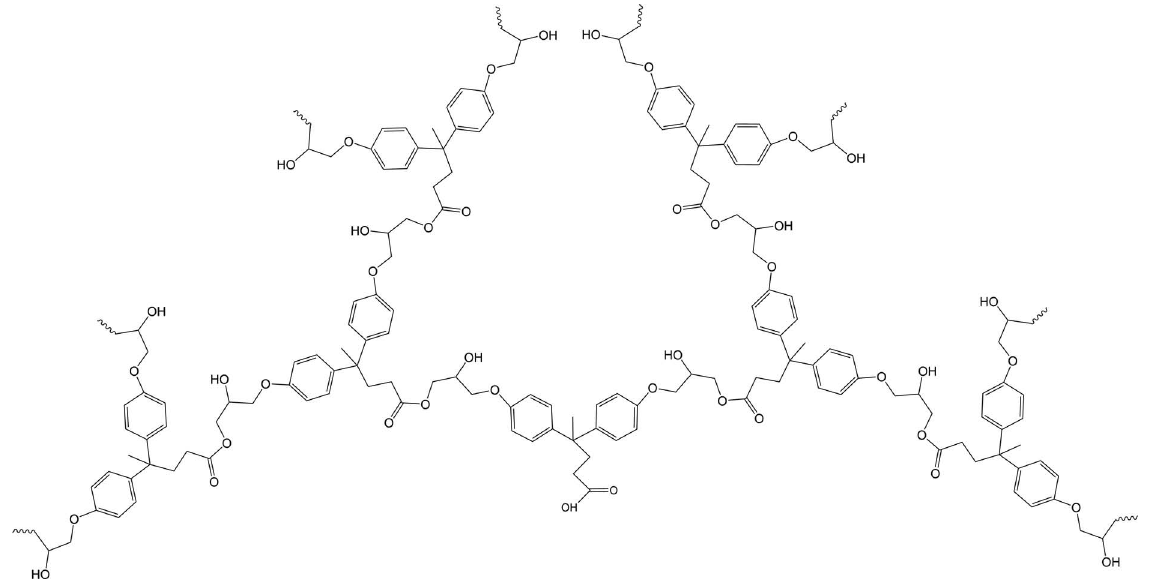
Figure 1: Chemical structure of